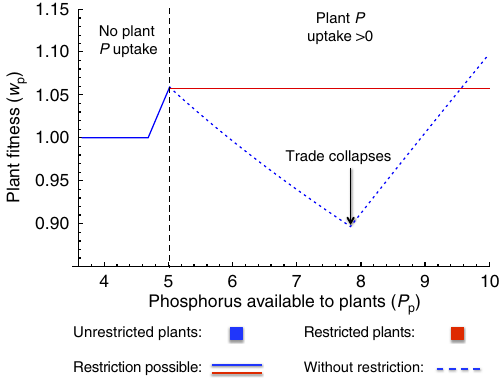
Figure 3 | Plant fitness with and without restriction. The impact of fungal restrictions on plant fitness changes with the phosphorus available for direct uptake by plants ( P p ). When plants do not acquire any phosphorus, restrictions are not favoured and so have no impact (left of black dashed line). When restriction does not happen, phosphorus acquisition by competitor plants reduces carbon supply (downward sloping dotted line), and can mean that restricted plants would have higher fitness (as shown in graph). When restrictions are not possible, trade collapses and plant fitness recovers to exceed fitness without restriction as P p increases (upward sloping dotted line). (In graph, n p ¼ 2, n f ¼ 12, C p ¼ 1.9, P f ¼ 5.5, a ¼ 0.17, b ¼ 0.6, e ¼